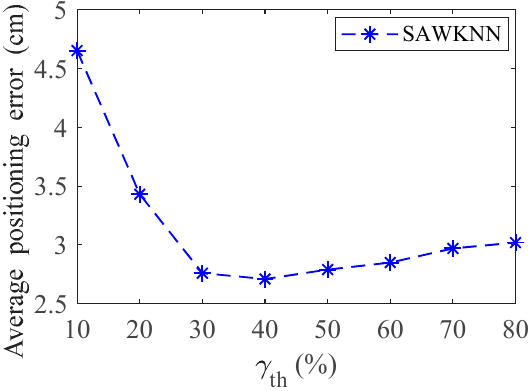
Figure 5. The impact of γ th on the average positioning error.